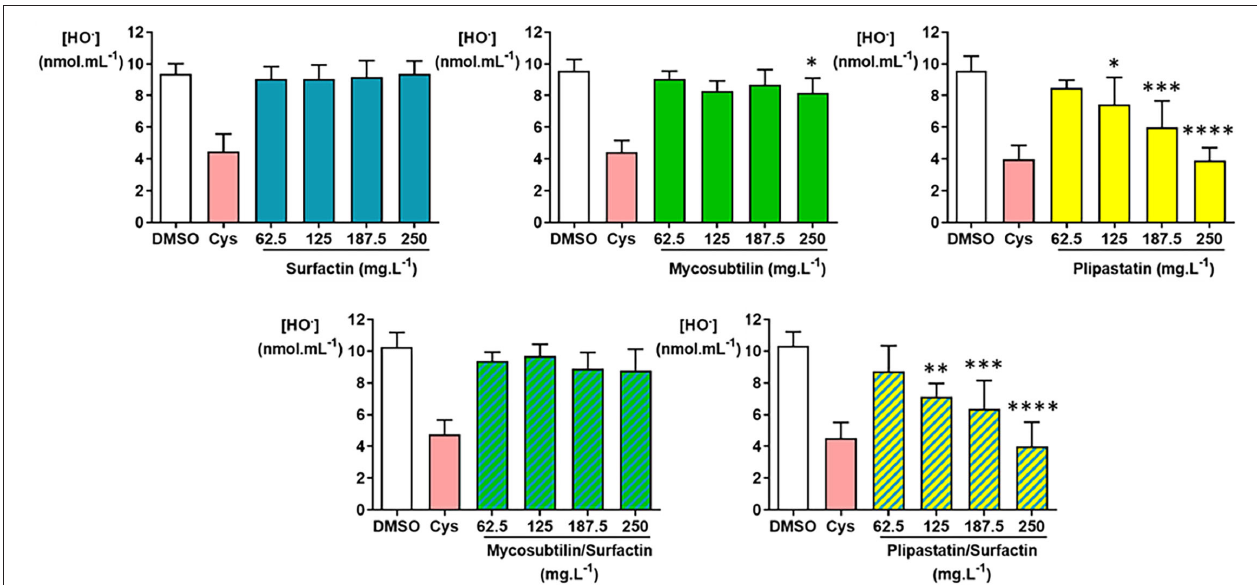
FIGURE 5 | Inhibition of the hydroxyl radical (HO . ) by the lipopeptides (surfactin, mycosubtilin, plipastatin, mixture of mycosubtilin/surfactin, and mixture of plipastatin/surfactin) in a cell-free model. The effects on HO . of lipopeptides tested at concentrations between 62.5 and 250mg.L − 1 (for the mixture, the indicated concentrations correspond to the concentration of each of the two lipopeptides) were compared to those of the DMSO-negative control. The positive control for HO . inhibition was cysteine (Cys) tested at 0.3 mmol.L − 1 . Statistical analysis of the data was performed with 6 independent experiments using ANOVA (overall Fisher’s test at the p = 0.05 level and Tukey’s multiple a posteriori comparison test) for mycosubtilin, plipastatin, mycosubtilin/surfactin, and plipastatin/surfactin and using the Kruskal-Wallis test (Dunn’s multiple a posteriori comparison test) for surfactin, with the GraphPad Prism software, * p < 0.05, ** p < 0.01, *** p < 0.001, **** p < 0.0001. Results are presented as a bar graph (means ±